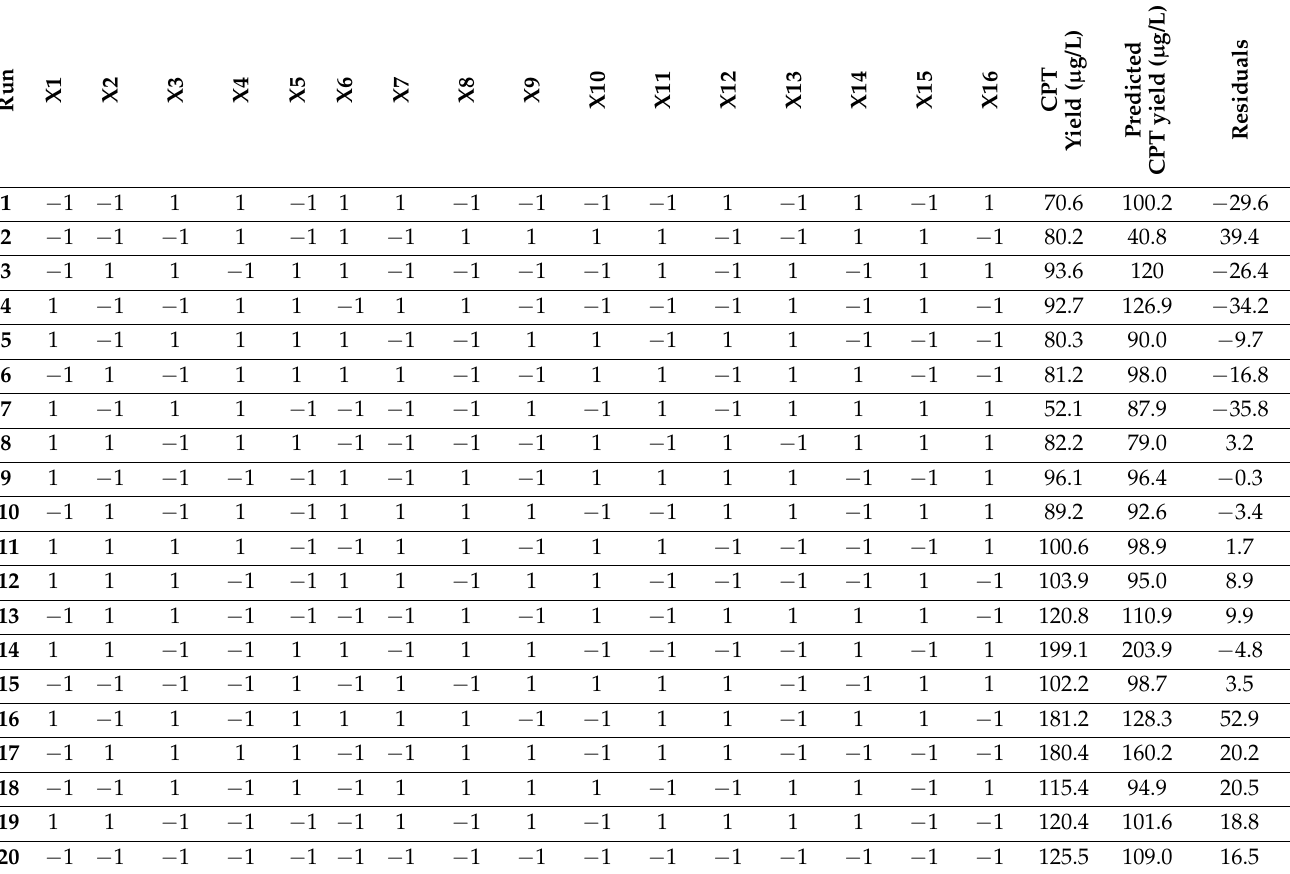
Table 3. Matrix of Plackett-Burman experimental design for camptothecin production by P. chrysogenum